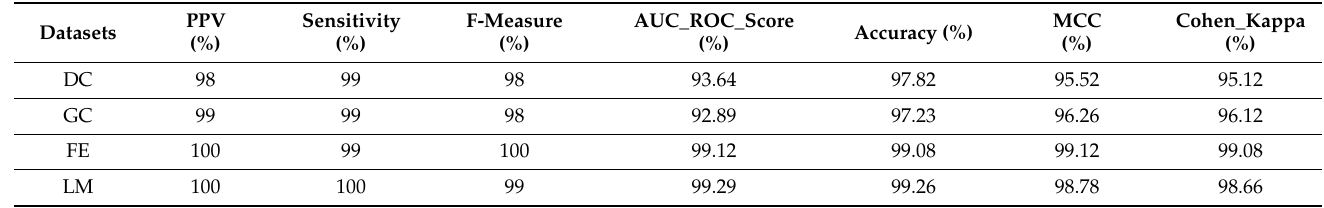
Table 11. Results of CNN algorithm.